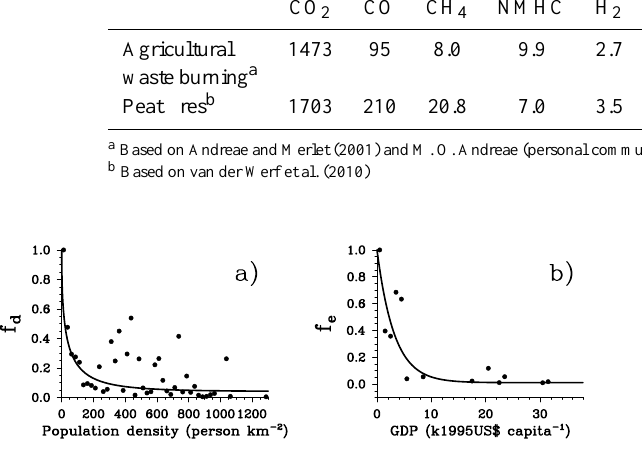
Fig. 3. Effects of (a) demographic situation f d , and (b) economic situation f e on burned area fraction (lines). Population density (per- sonkm − 2 ) and gross domestic product (GDP, k1995US$capita − 1 ) are used as socioeconomic indicators. In regions where area frac- tion of crop PFTs is larger than 50%, we partition 1997–2004 average 0.5 ◦ GFED3 burned area fraction divided by f e (i.e., ( A b ) GFED3 /f e ) over 25personkm − 2 population density bins, and A g ) GFED3 /f d ) GFED3 burned area fraction divided by f d (i.e., ( A b A g over 1k1995US$capita − 1 GDP bins. Black circles indicate the (normalized) average in bins with sample size > 5. Goodness of fit is R 2 = 0 . 46 ( n = 42) in (a) and R 2 = 0.70 ( n = 13) in (b)